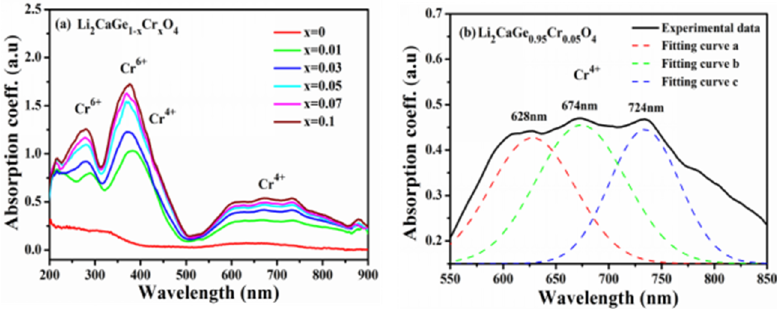
Figure 7. Li 2 CaGe 1–x Cr x O 4 crystal absorption spectra: ( a ) Absorption spectra of crystals with different doping concentrations (200–900 nm); ( b ) the Gaussian of Li 2 CaGe 0.95 Cr 0.05 O 4 (550–850 nm).